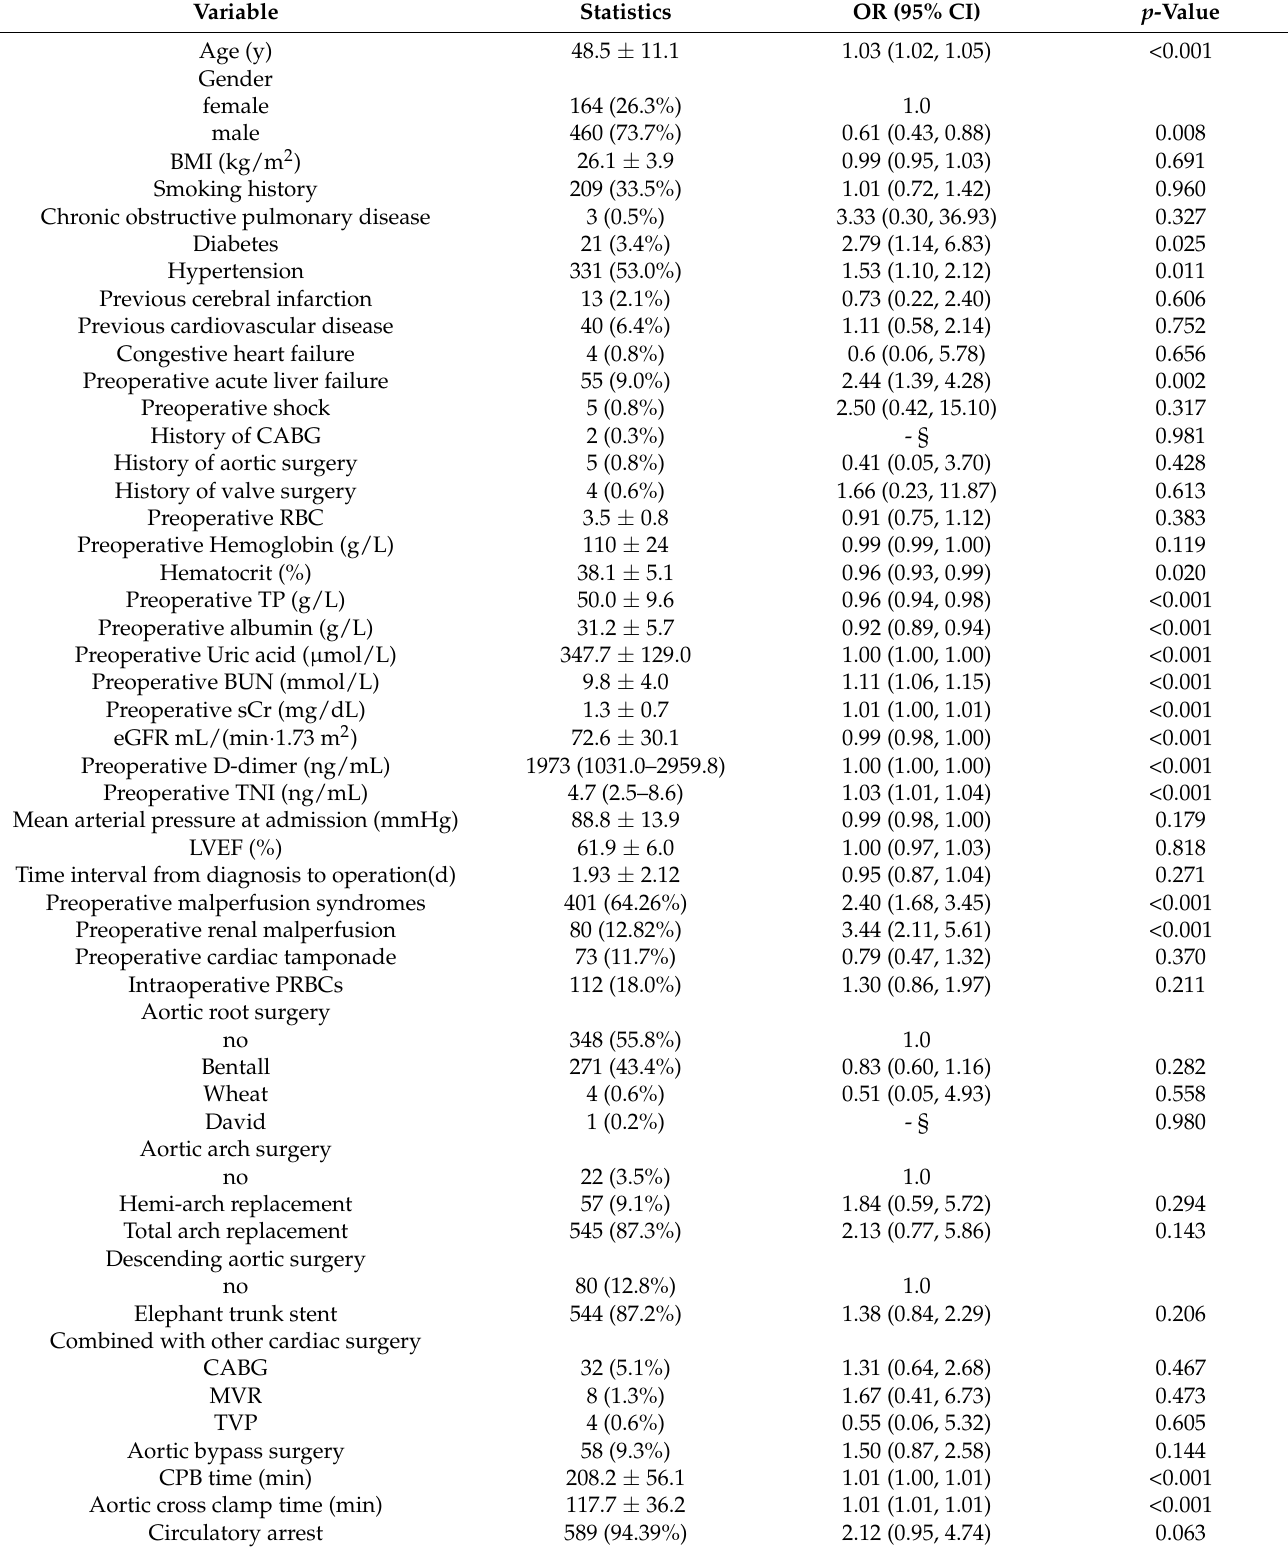
Table 2. Univariate analysis of risk factors associated with postoperative acute kidney injury in patients with acute type A aortic